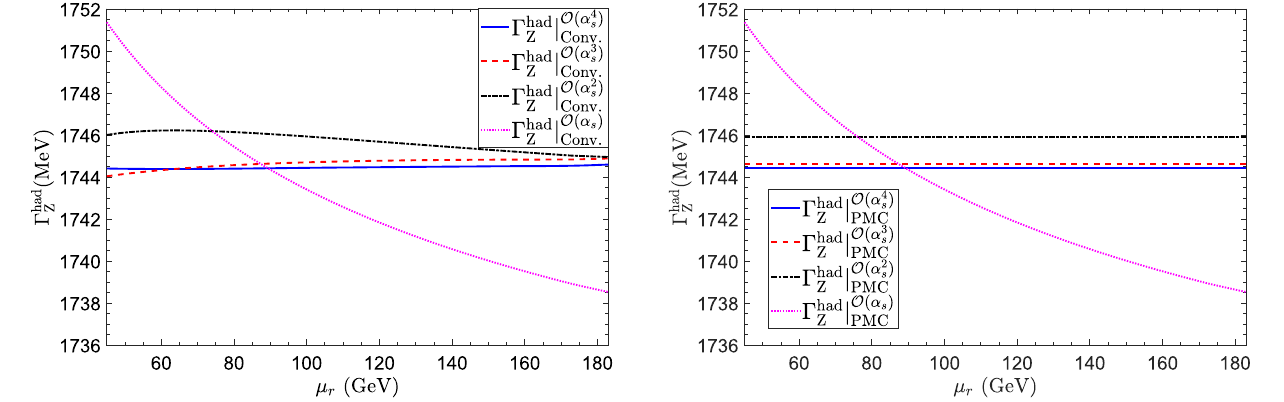
undertheconventional Z